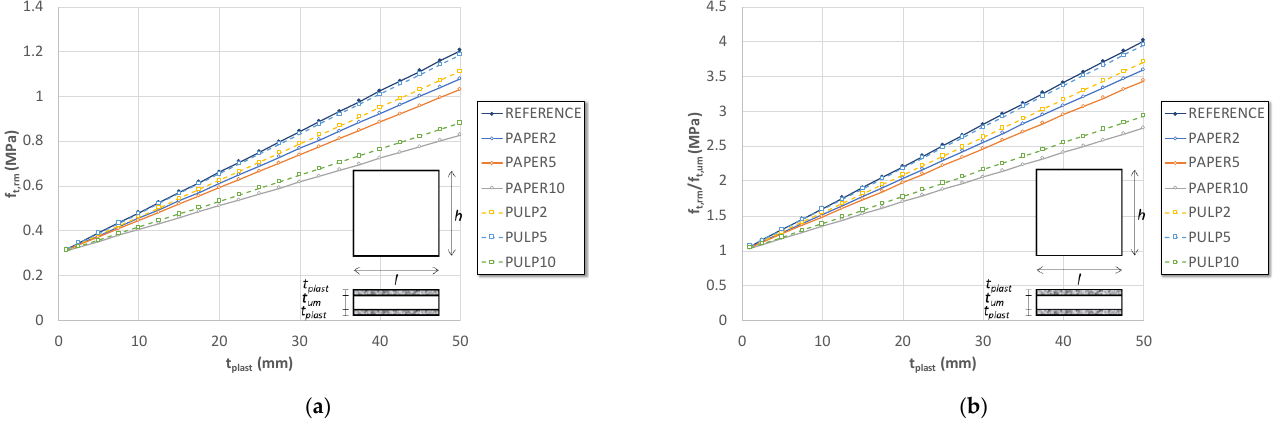
Figure 6. ( a ) Equivalent tensile strength of reinforced masonry f t,rm , ( b ) ratio between the equivalent tensile strength of reinforced ( f t,rm ) and unreinforced ( f t,um ) masonry.